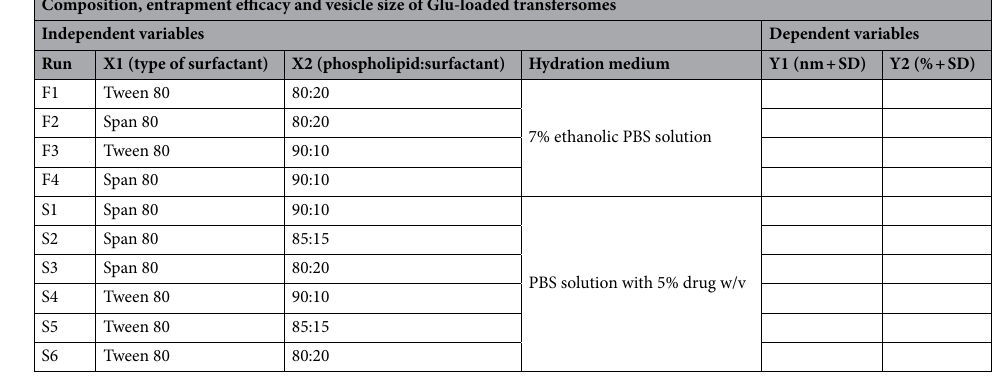
Table 1. Formulations of glucosamine sulphate loaded transfersome. where X1 = type of surfactant; X2: phospholipid: surfactant ratio; X3 = hydration medium used with 5% drug w/v; Y1 = vesicle size; Y2 = entrapment